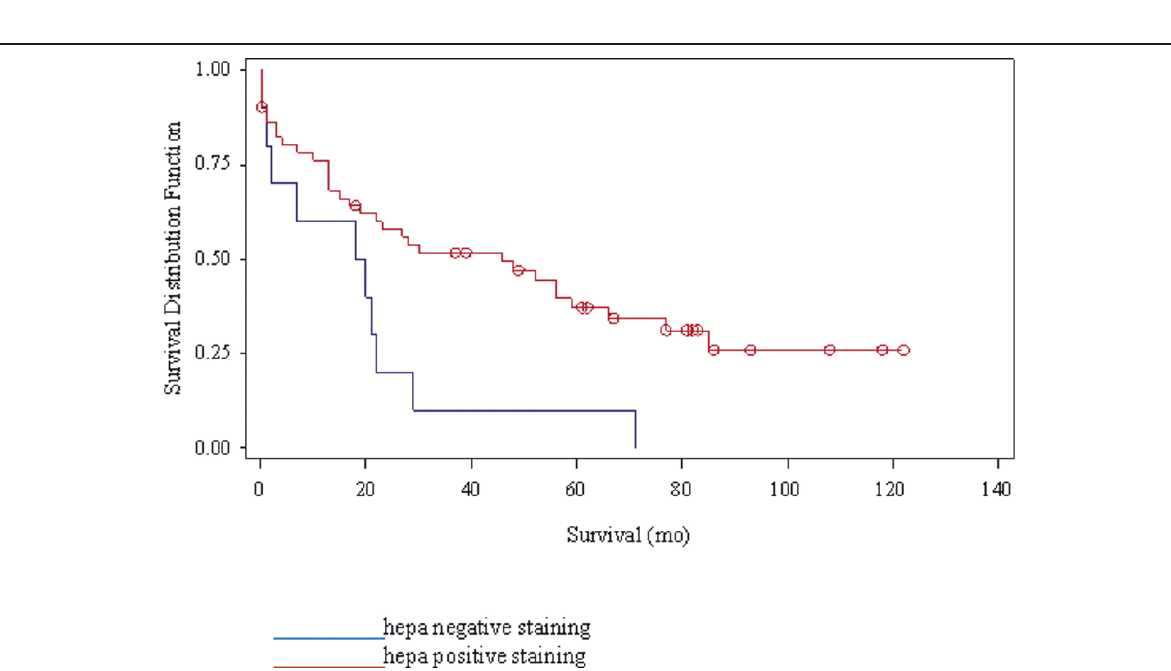
Figure 3 Kaplan-Meier analysis: A significant difference in survival time between positive and negative SCCA immunostaining groups